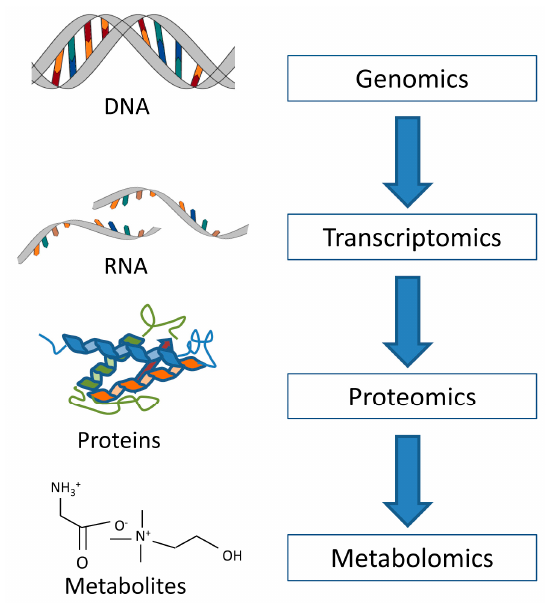
Figure 1. The omics cascade. Metabolomics is the final step in the cascade, and thus studies information closer to the phenotype than the preceding omics.